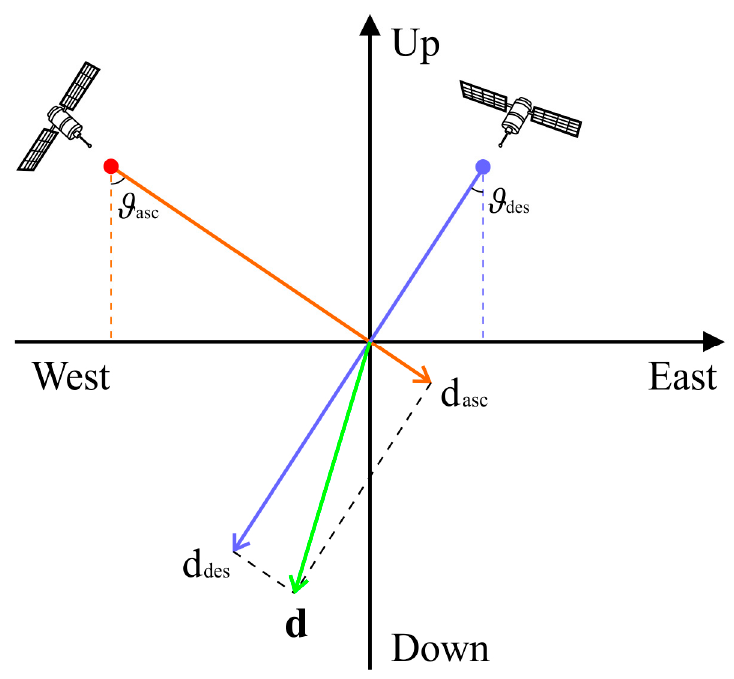
Figure 3. SAR observation geometries of the ascending (orange) and descending (blue) data tracks.